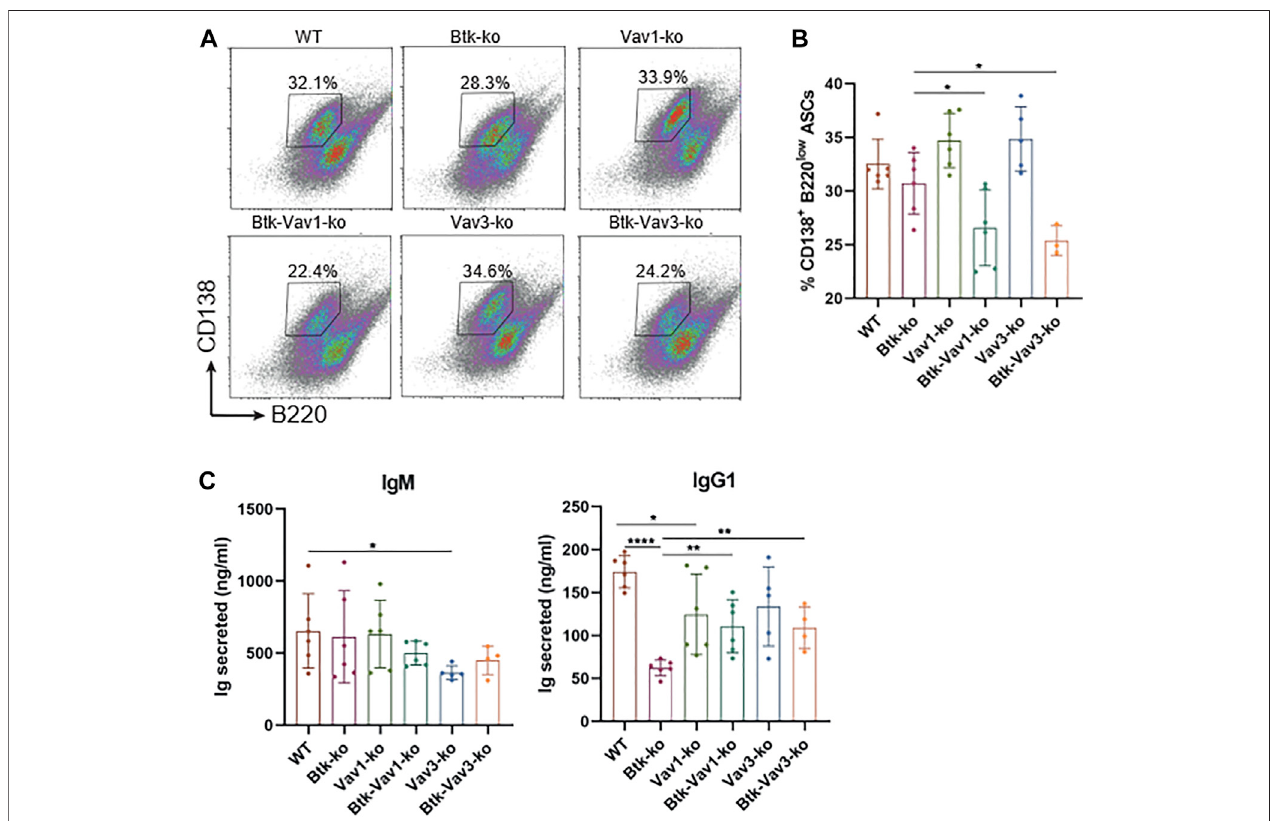
FIGURE 7 | Vav protein de fi ciency impairs B cell differentiation into ASCs in vitro . Naïve B cells were isolated from respective mouse strains and cultured in the presence of CD40 and IL4 for 7 days. (A. B) On day 4, cells were collected and analyzed for the presence of CD138 + B220 low ASCs by fl ow cytometry. Representative fl ow cytometry plots for each genotype ( A ) and statistical analysis (B) are shown. (C) On day 7, culture supernatants were collected and secreted amounts of IgM and IgG1 are shown. Data are merged from three independent experiments. * p < 0.05, ** p < 0.01, and *** p < 0.001. p -values were determined using a two-tailed Student ’ s t test or Mann-Whitney-U test. Mice were analyzed in an age range from 10 – 13 weeks